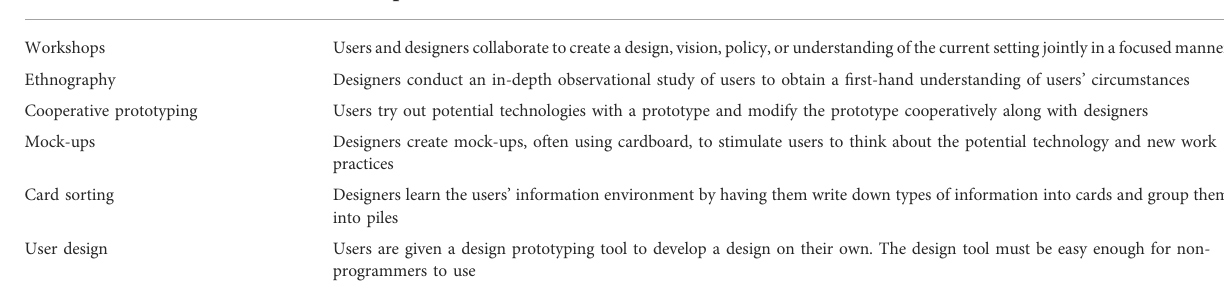
TABLE 1 Methods of participatory